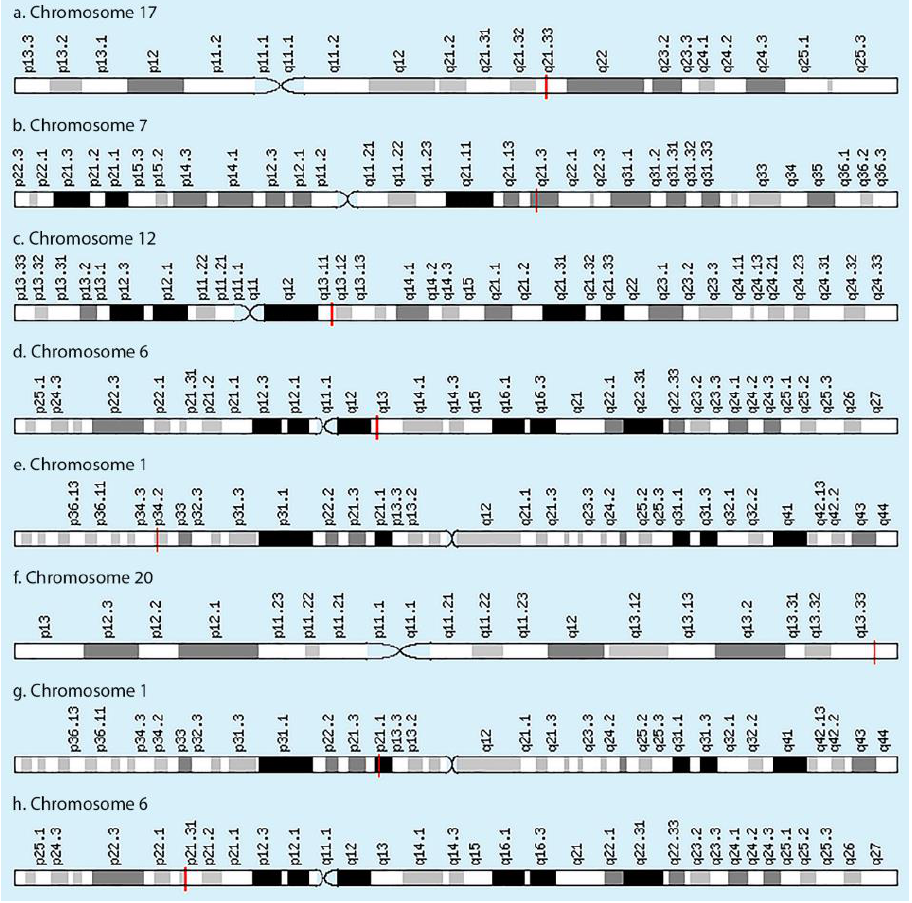
Figure 3. Chromosomal localization of the collagen-encoding genes: ( a ) COL1A1 ; ( b ) COL1A2 ; ( c ) COL2A1 ; ( d ) COL9A1 ; ( e ) COL9A2 ; ( f ) COL9A3 ; ( g ) COL11A1 ; ( h ) COL11A2 . Thus, monogenic diseases caused by mutations of COL1A1 , COL1A2 , COL2A1 , COL9A1